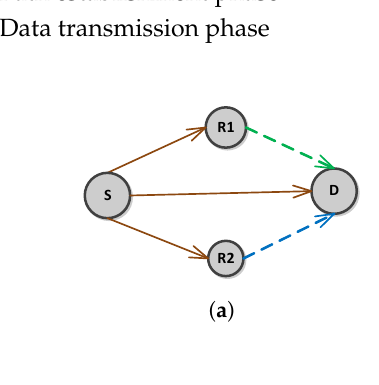
Figure 5. System model. ( a ) ACE; ( b )